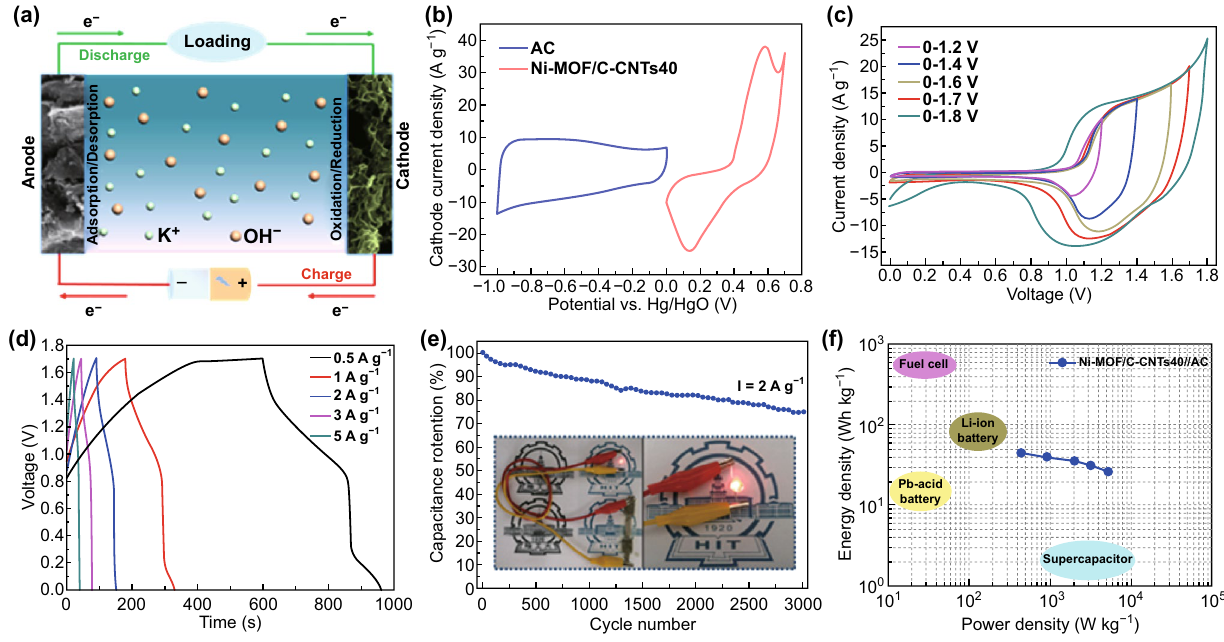
Fig. 5 a Schematic illustration of the MOF/C-CNTs40//AC HSC device. b CV curves of Ni-MOF/C-CNTs40 and commercial AC electrodes at 5 mV s −1 in three-electrode system, respectively. c CV curves of the HSC device in various voltages at 20 mV s −1 . d GCD curves of the HSC device at various current densities. e Cycling performance at the current density of 2 A g −1 and two devices in series can lighten up a red LED indicator (inset). f Ragone plots of HSC